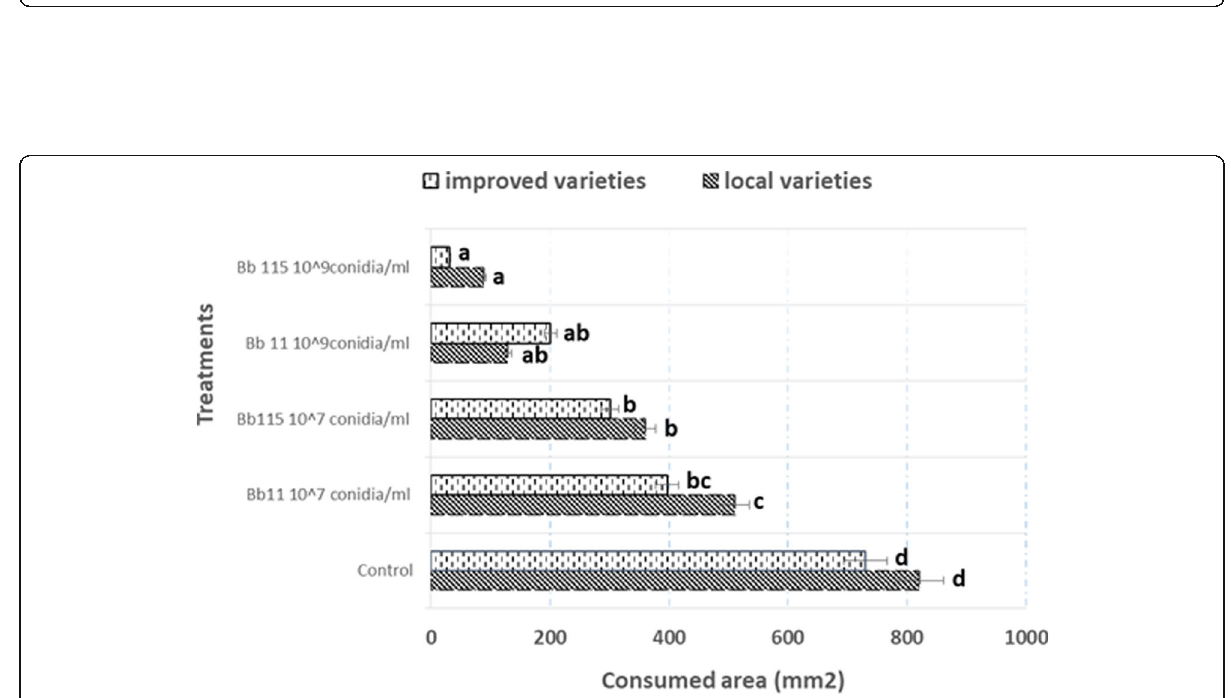
Fig. 5 Leaf areas consumed by Helicoverpa armigera larvae when offered inoculated and non-inoculated tomato plants. Histograms with the same letters are not significantly different at the 5% level (SNK). With Bb115 10 9 conidia/ml = Beauveria bassiana Bb115 at 10 9 conidia/ml; Bb11 10 9 conidia/ml = Beauveria bassiana Bb11 at 10 9 conidia/ml; Bb115 10 7 conidia/ml = Beauveria bassiana Bb115 at 10 7 conidia/ml; Bb11 10 7 conidia/ml = Beauveria bassiana Bb11 at 10 7